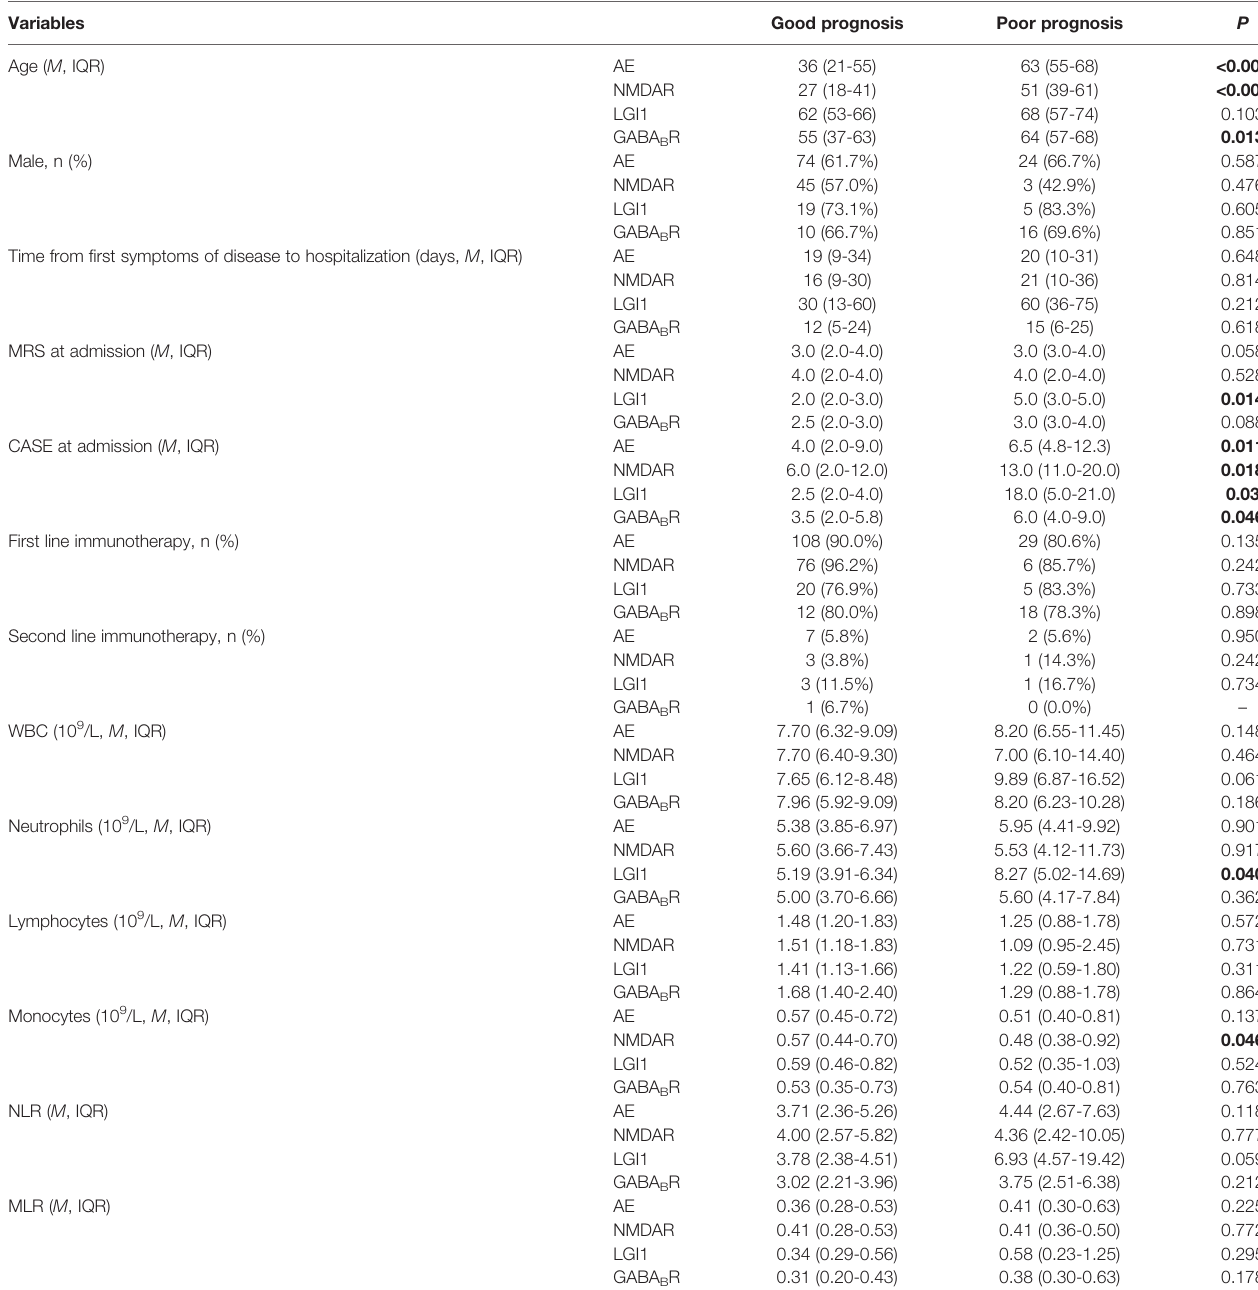
TABLE 5 | Univariate logistic regression analysis of factors associated with poor prognosis.